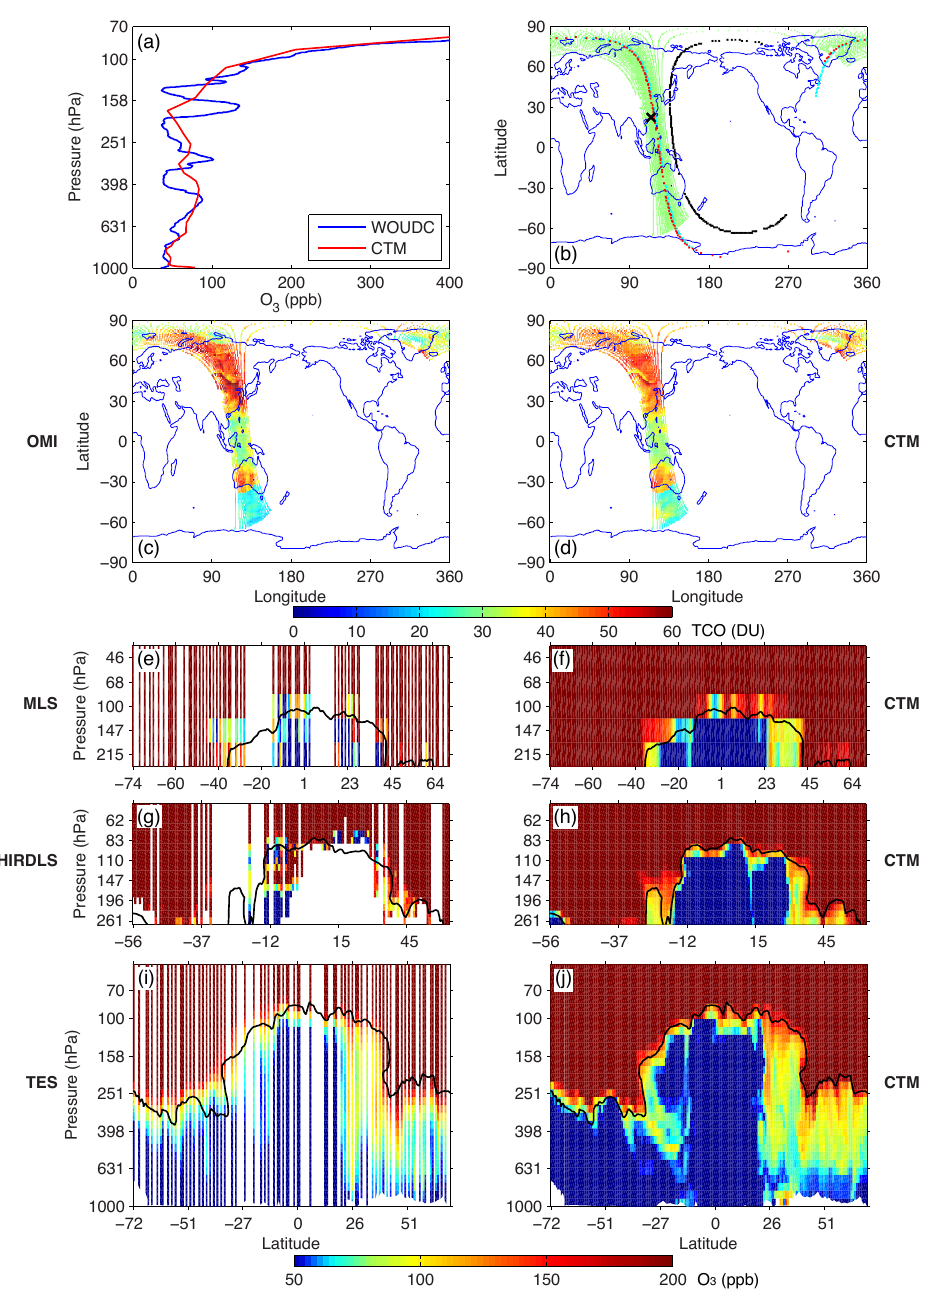
Fig. A1. Same as Fig. 3 for 27 July 2005. The sonde was measured at 05:22UTC, compared with model simulation at 06:00UTC in (a) . The Aura and CTM swaths are for 05:00–06:00UTC. (c) – (j) show the swaths in 0 ◦ –180 ◦